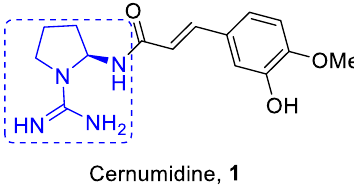
Figure 1. Structure of cernumidine ( 1 ); in marked blue is the 2-aminopyrrolidine-1-carboxamidine unit presenting the cyclic-guanidine core.